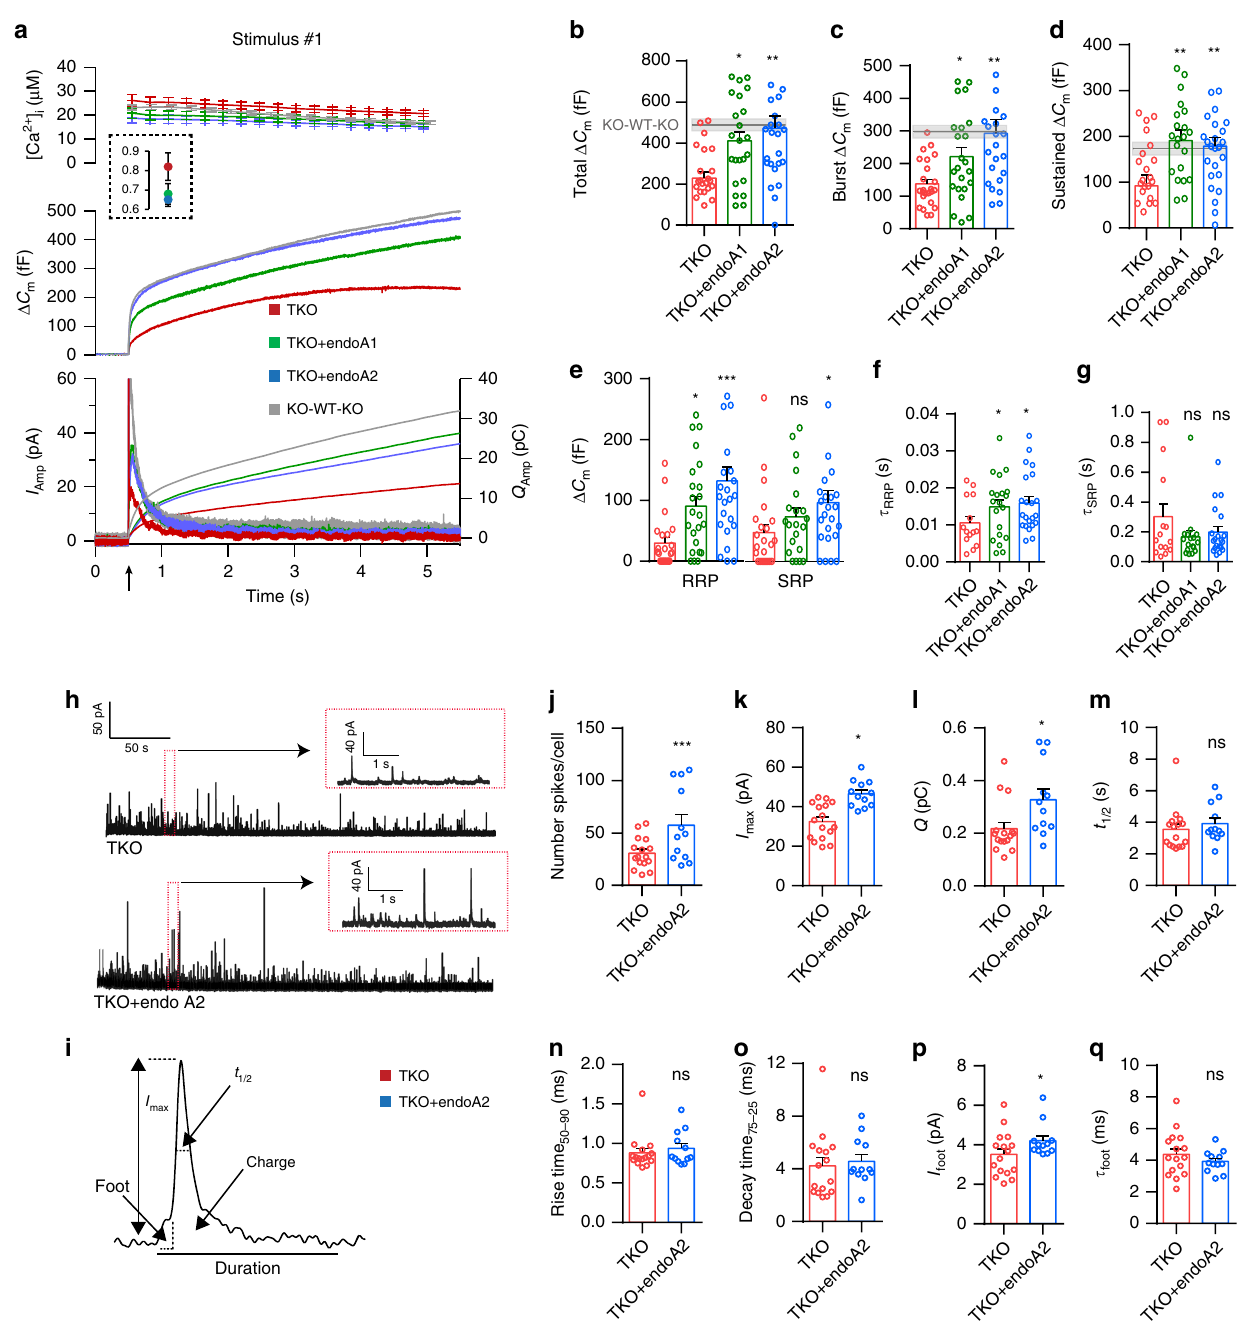
Fig. 2 Expression of endophilin 1 and endophilin 2 rescued exocytosis in endophilin TKO cells. a , b Expression of endophilin 1 and endophilin 2 full-length rescued the exocytic defects seen in endophilin TKO cells. Panel arranged as in Fig. 1i, with three groups: endophilin TKO (red traces; N = 4, 4 mice (24 cells)), TKO + endophilin 1 (green traces; N = 4, 4 mice (23 cells)) and TKO + endophilin 2 (blue traces; N = 4, 4 mice (25 cells)). Control KOWTKO data from Fig. 1I (gray trace; N = 4, 6 mice (32 cells)) are superimposed. Note that both endophilin 1 and endophilin 2 can rescue exocytosis; rescue with endophilin 2 is indistinguishable from control KOWTKO cells. c – e Burst and sustained component, as well as RRP size, were rescued upon expression of endophilin 1 and 2, respectively. f , g The altered kinetics of the RRP in TKO was rescued ( f ), while the time constant of the SRP was not signi fi cantly changed ( g ) upon expression of endophilin 1 and 2, respectively ( b – g ) Kruskal – Wallis test with Dunn ’ s multiple comparison test. h Exemplary traces from amperometric recordings of endophilin TKO and endophilin TKO expressing endophilin 2. Insets show magni fi ed view. i Schematic of analyzed amperometric spike parameters. j – q Amperometry analysis (210 s recording per cell) reveals problems in vesicle fusion: number of fusion events per cell ( j ), single spike amplitude ( k ) and charge ( l ) were signi fi cantly decreased in endophilin TKO cells, while the kinetics of single fusion events, such as duration at half-maximal amplitude ( m ), rise time ( n ), and decay time ( o ), was unchanged. The stability of the fusion pore was also altered, as shown by shorter foot amplitude ( p ) while the foot duration ( q ) was not changed. TKO: 2 mice (16 cells), TKO + endophilin: 2 mice (12 cells) — each cell is a biological replicate. Error bars denote SEM. N = number of independent replicates. Unpaired two-sided t -test. * p < 0.05, ** p < 0.01, *** p < 0.001, ns not signi fi